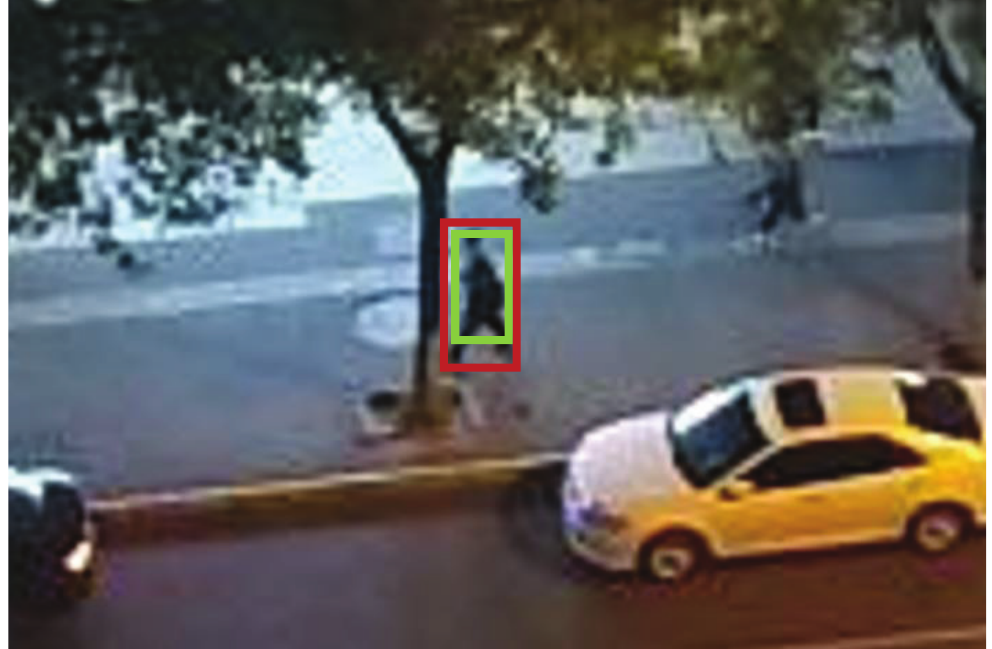
Figure 4. Subjective factors in the labeling process.